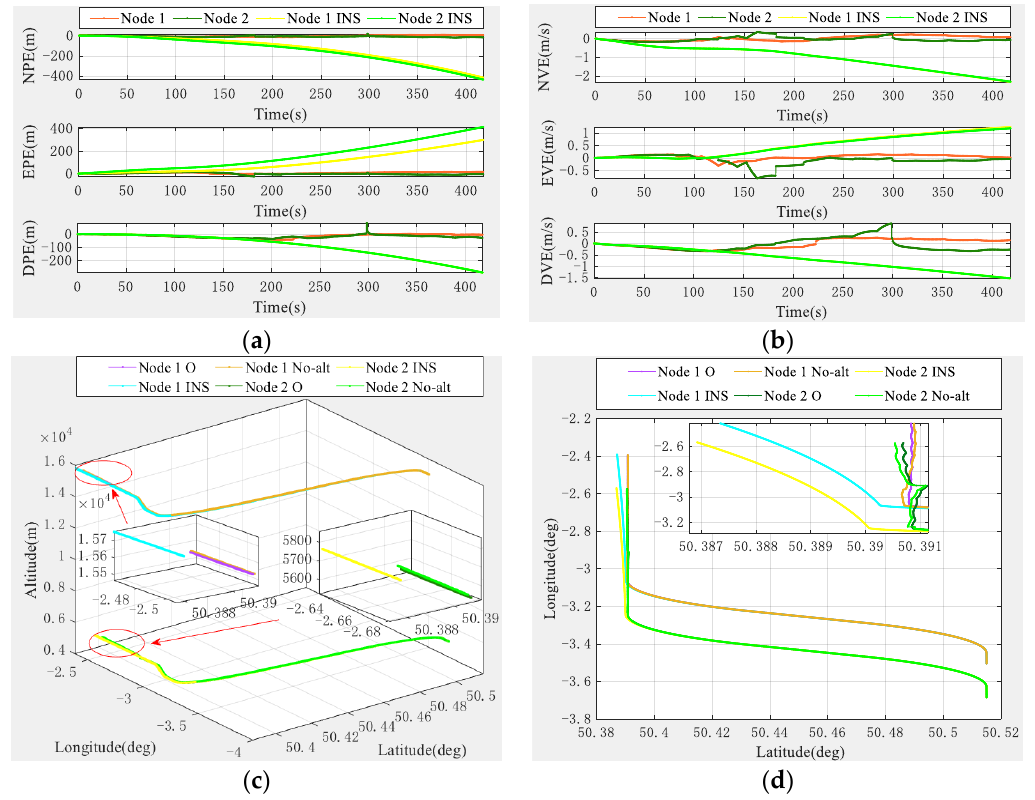
Figure 5. Positioning error curve of joint navigation without an altimeter assistance. ( a ) Position error curve, ( b ) velocity error curve, ( c ) 3D trajectory error curve, and ( d ) 3D projection error curve.